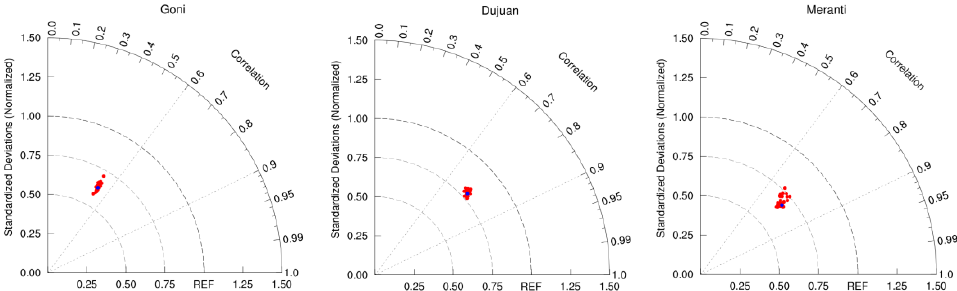
Figure 10. Taylor diagrams of the significant wave height for the three typhoon events and 27 experiments. Red dots stand for experiments, and blue dots stand for ensemble prediction.